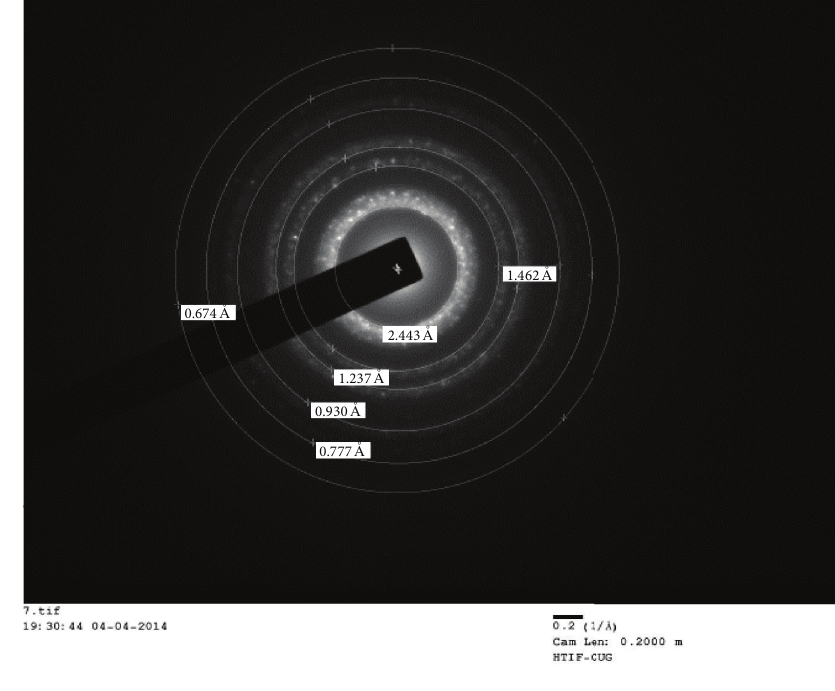
Figure 6: SAED pattern of Pd2MBA. Table 1: Antimicrobial activity of Pd (II)